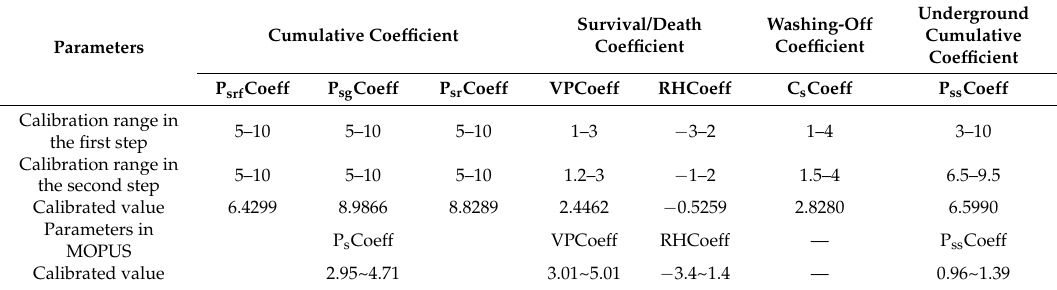
Table 3. Parameters calibration range and the value of calibrated